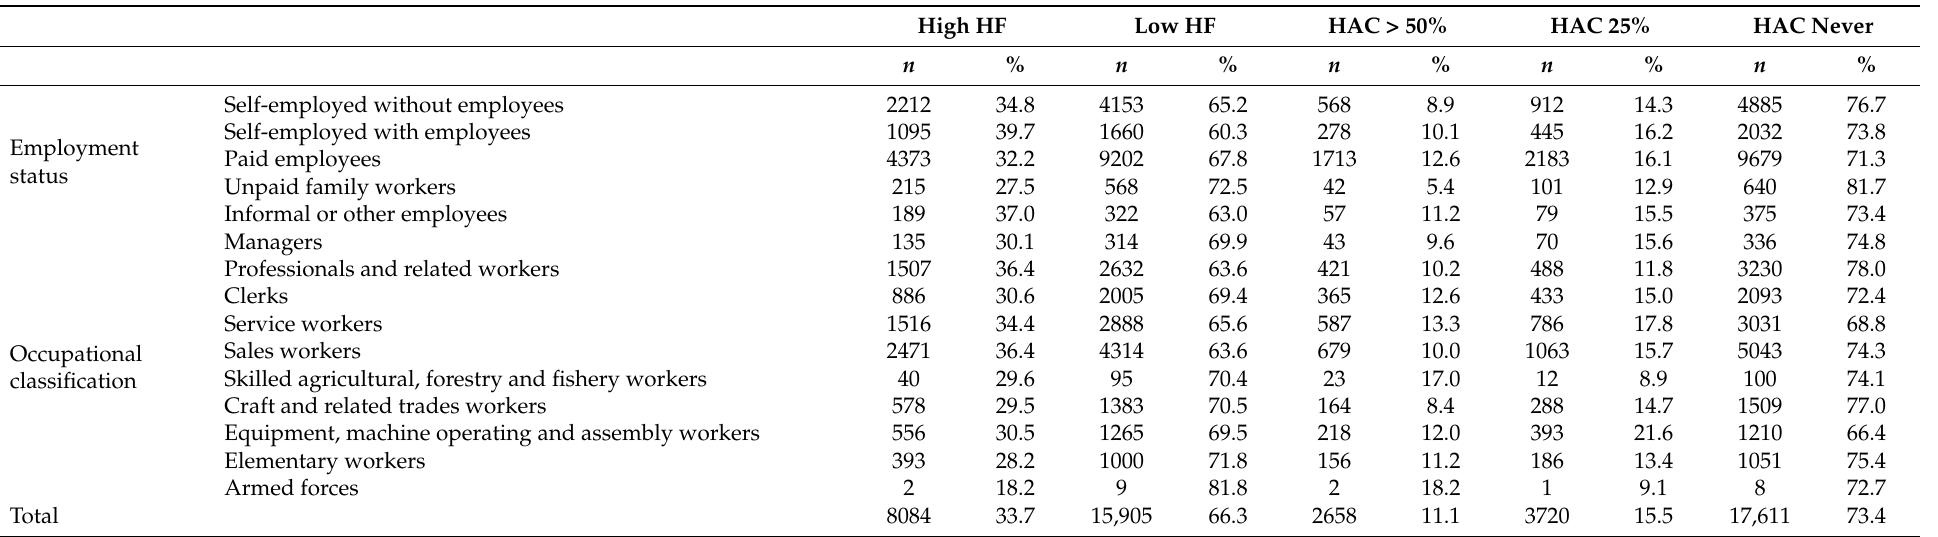
Table 2. Emotional demands by employment status and occupational